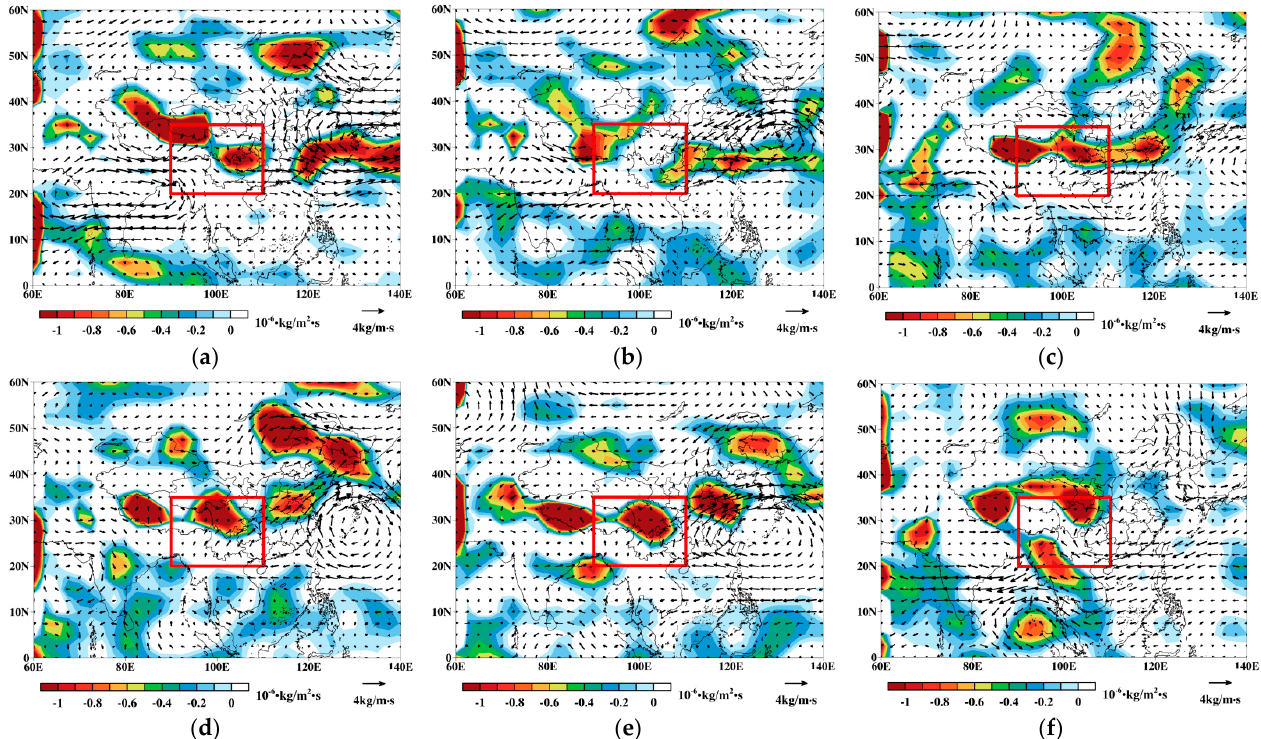
Figure 23. Homochromous whole-layer water vapor flux integral and water vapor divergence in the second cycle of 30–60 days ISO in 1998. (Unit of water vapor flux integral: kg·m − 1 ·s − 1 ; unit of divergence: 10 − 6 ·Kg·m − 2 ·s; ( a – f ) means phases 1–6; area in red box is southwest China.). divergence: 10 − 6 · Kg · m − 2 · s; ( a – f ) means phases 1–6; area in red box is southwest